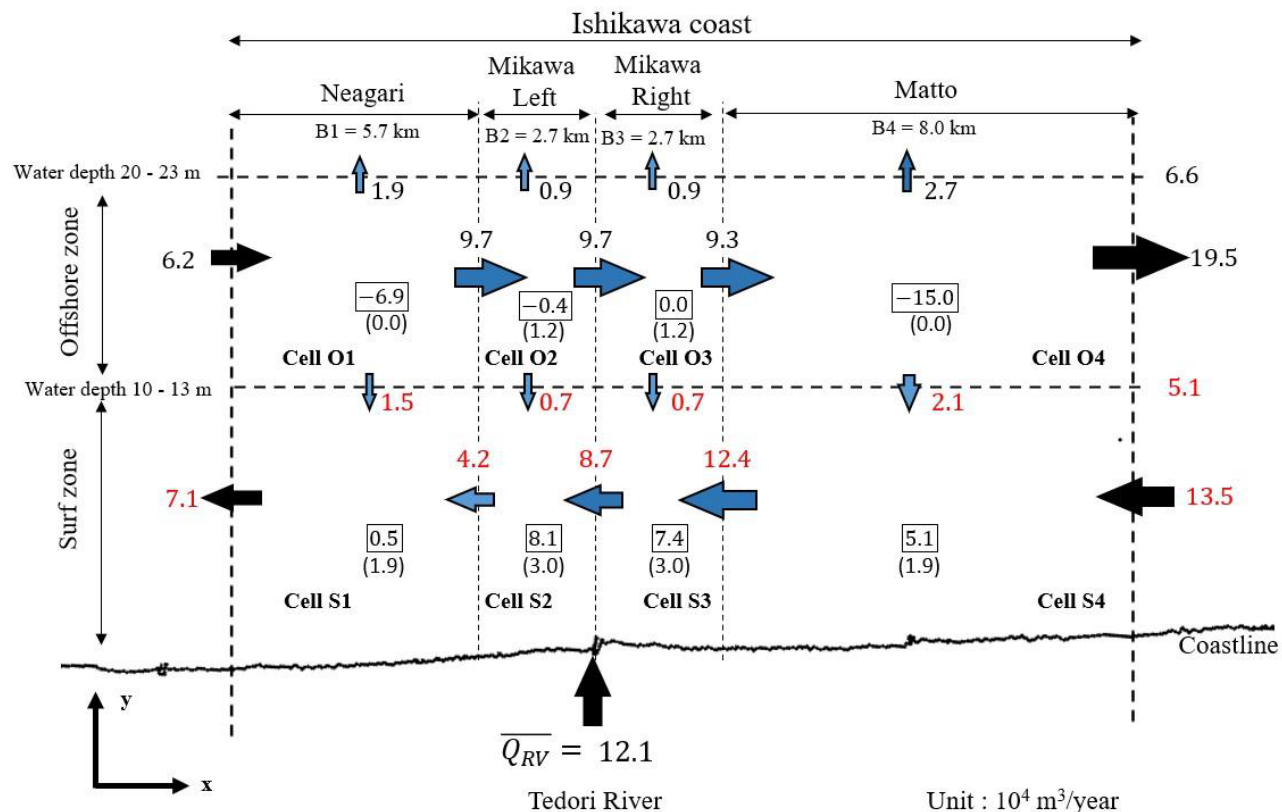
Figure 10. The sediment budget of the Ishikawa coast estimated in relation to the base condition (BC). The arrow value denotes net sediment transport, and the square value shows sediment volume change. The values in the blanket depict the supplied river sediment.